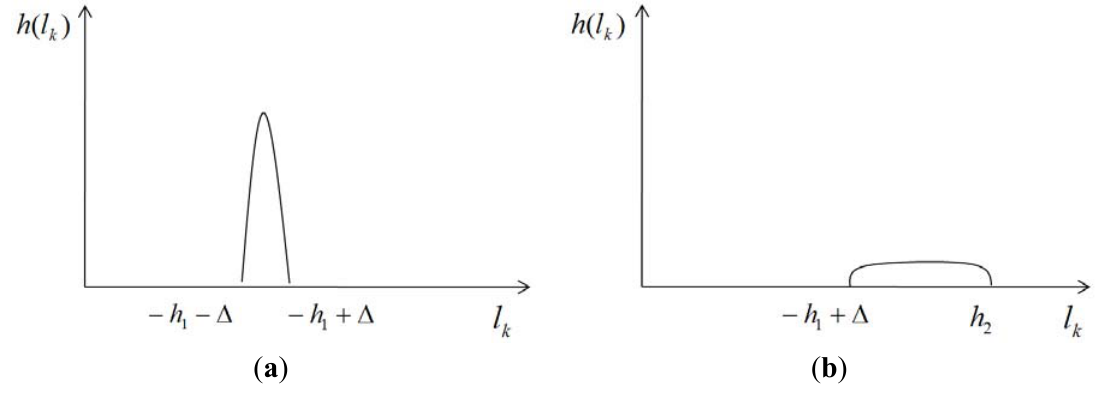
Figure 3. Histogram examples of height value distributions. ( a ) A height histogram for ground data. ( b ) A height histogram for non-ground data.